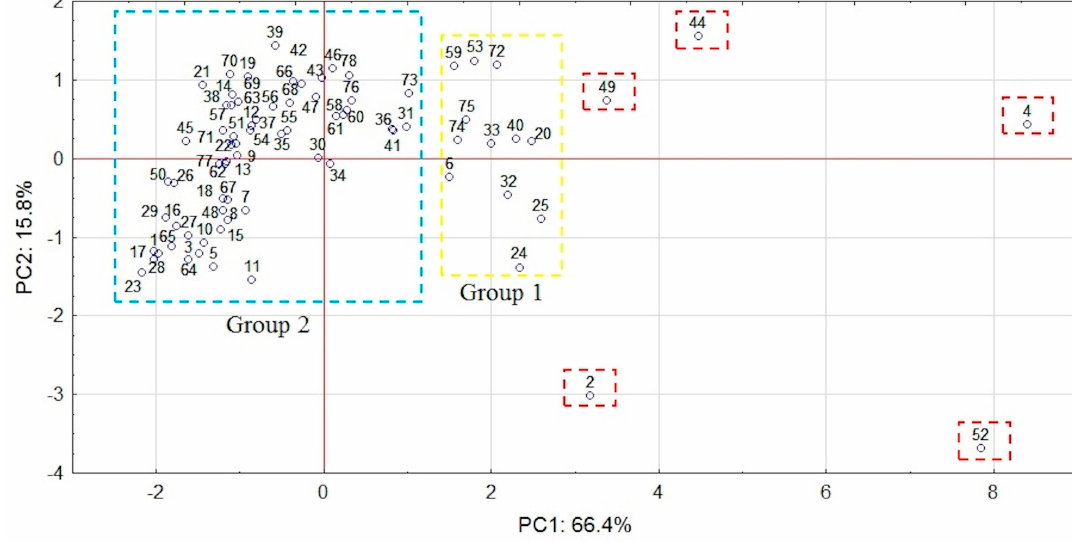
Figure 6. Factor values obtained from principal component analysis (PCA) for sampling points and classified according to the cluster analysis (CA) results. Following the rigorous statistical approach, outliers should be identified and eliminated prior to implementation of PCA, which is sensitive to outliers [64]. Generally, observation that differs from the majority of data is considered an outlier [65]. However, identification of outliers within real data is not effortless [66]. In the case of environmental data, anomalous results may be caused by an analytical error, but they can also indicate hot-spots [62]. Therefore, five outliers (2, 4, 44, 49, and 52) were eliminated, PCA was repeated and the results were compared with calculations on the complete dataset. This approach yielded two main components (Figure S4) with the contribution 79.6% to the total variance. PC1 was influenced by all metal contents. Their factor loadings were within the range from –0.95 to –0.79 for Cd and Cu, respectively. PC1 and PC2 were negatively correlated with pH (factor loadings –0.62 and –0.72, respectively). PC2 has also weak positive loadings for Pb (0.36) and Cu (0.29). Overall, the obtained statistical pattern is similar to the results of the analysis with outliers. Significant correlations are still observed among metals. The score plot (Figure S5) indicates that sampling points are divided into three main groups. Group I contains the same sites as selected by the first PCA and these sites are strongly influenced by PC1. The remaining points are in groups II and III. Elimination of hot-spots prompted diversity of pollution loads, especially in areas characterized by high metal contents like the center of Ł ód ź . Therefore, the removal of hot-spots led to the loss of the data critical to the habitat and health of the inhabitants.